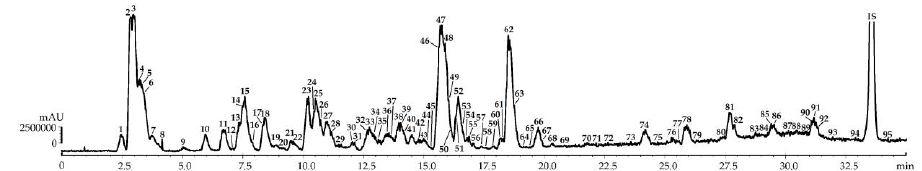
Figure 2. High-Performance Liquid Chromatography with Electrospray Ionization Triple Quadrupole Mass Spectrometric Detection (HPLC-ESI-tQ-MS) chromatogram (Total Ion Chromatogram (TIC) mode, negative ionization) of extract of F. viridis ripe fruits: compounds are numbered as listed in Table 1. IS—internal standard (genkwanin). Table 1. Chromatographic ( t R ) and mass-spectrometric data of compounds 1 – 95 found in F. viridis fruits.